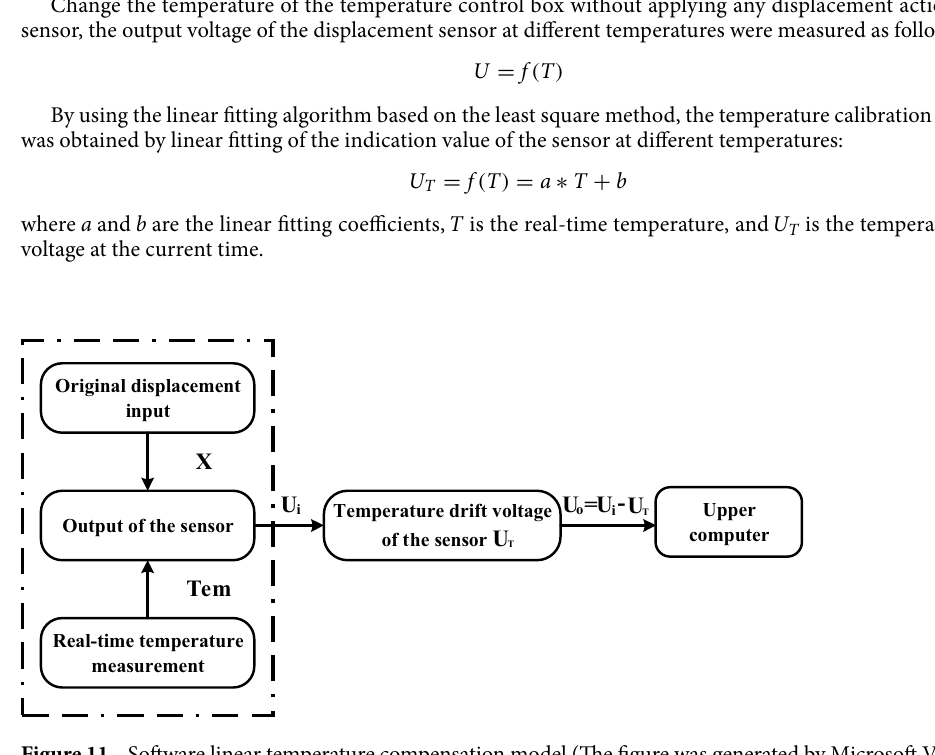
Figure 11. Software linear temperature compensation model (The figure was generated by Microsoft Visio Professional 2016 (https:// www. micro soft. com/ zh- CN/ downl oad/ detai ls. aspx? id=